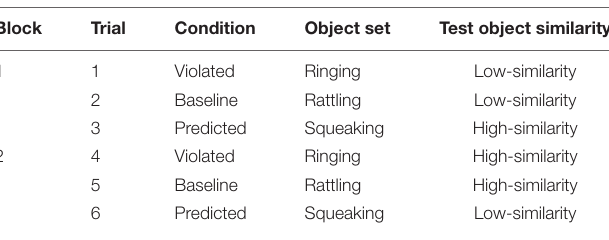
TABLE 3 | Example testing